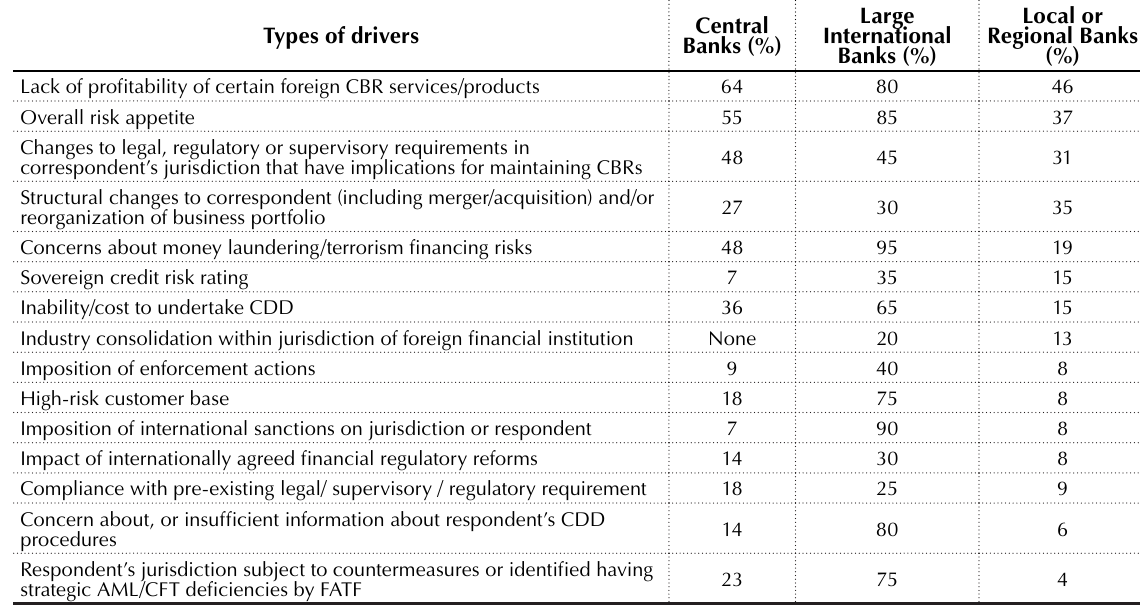
Table 2. Comparison of the drivers of termination or restriction of foreign correspondent banking services